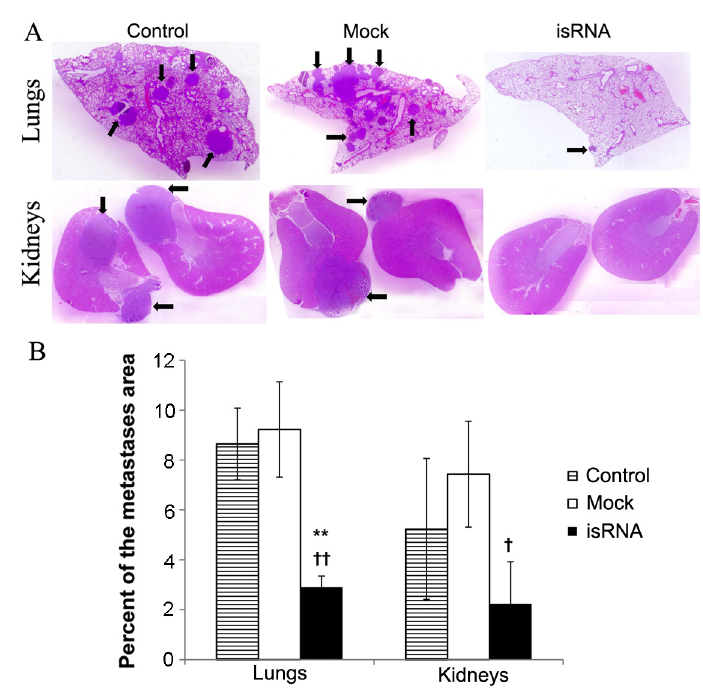
row) of the representative mice from different groups on day 15 after intravenous B16 tumor cell implantation. Arrows show the metastases. Paraffin sections, hematoxylin and eosin stain. (B) The ratio of the